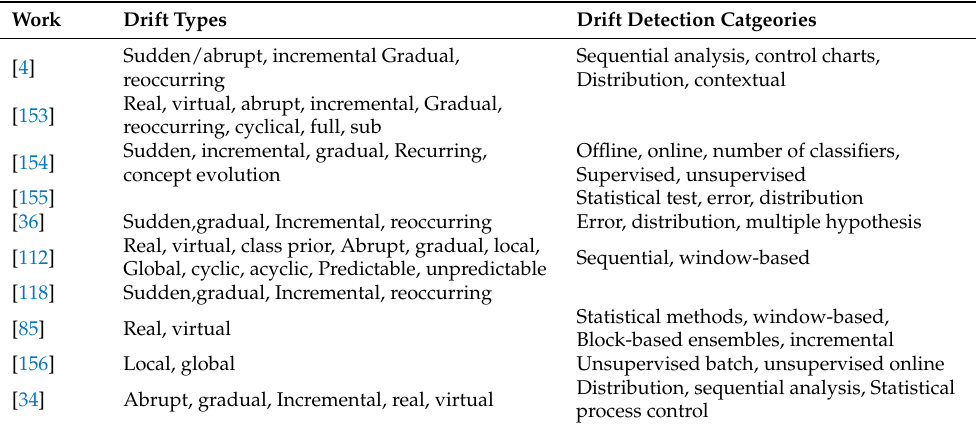
Table 6. Overview of summarizing drift detection work and used terminologies of drift types, as well as detection algorithm